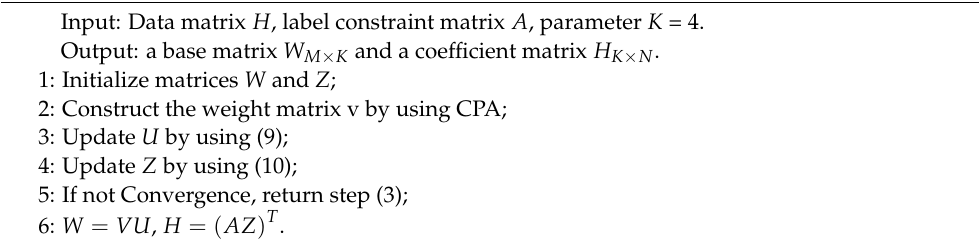
Algorithm 1. Dual Semi-Supervised Convex NMF (DCNMF)